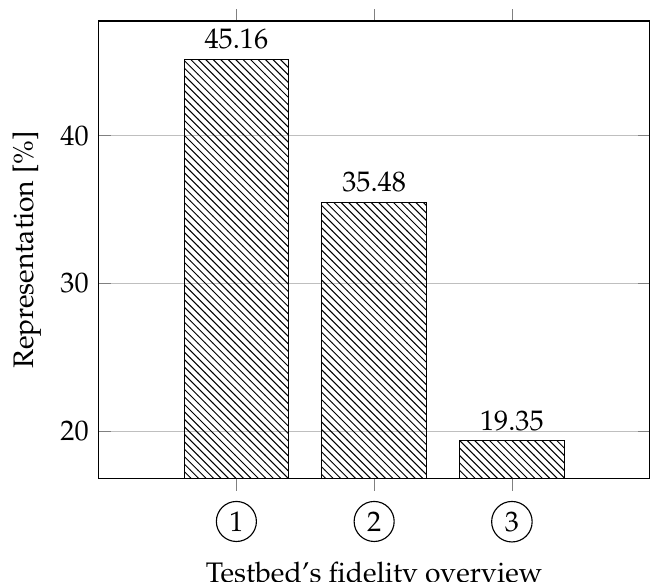
Figure 18. The percentage of selected testbeds’